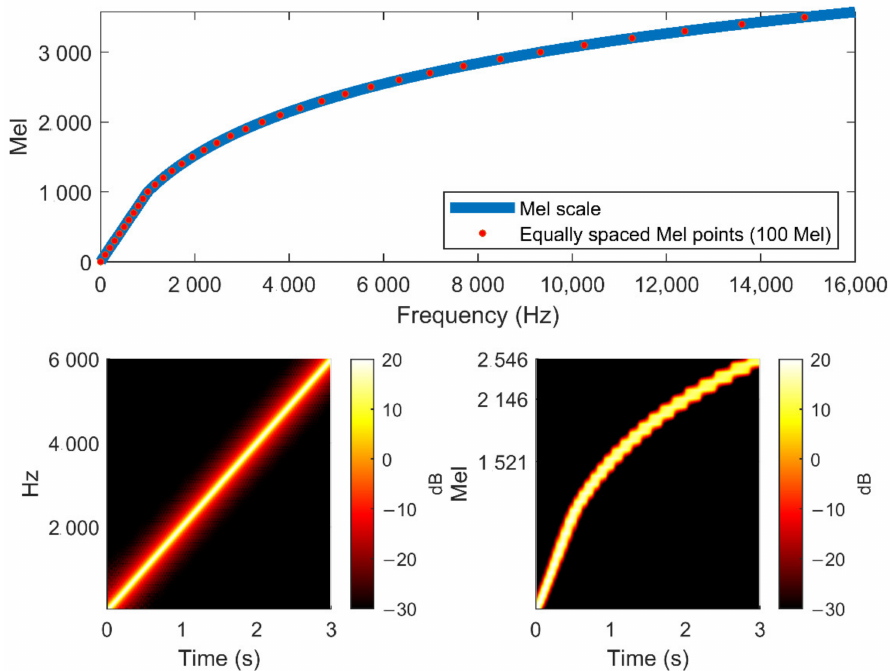
Figure 4. Mel scale ( top ). Traditional spectrogram ( bottom left ). Mel spectrogram ( bottom right ).